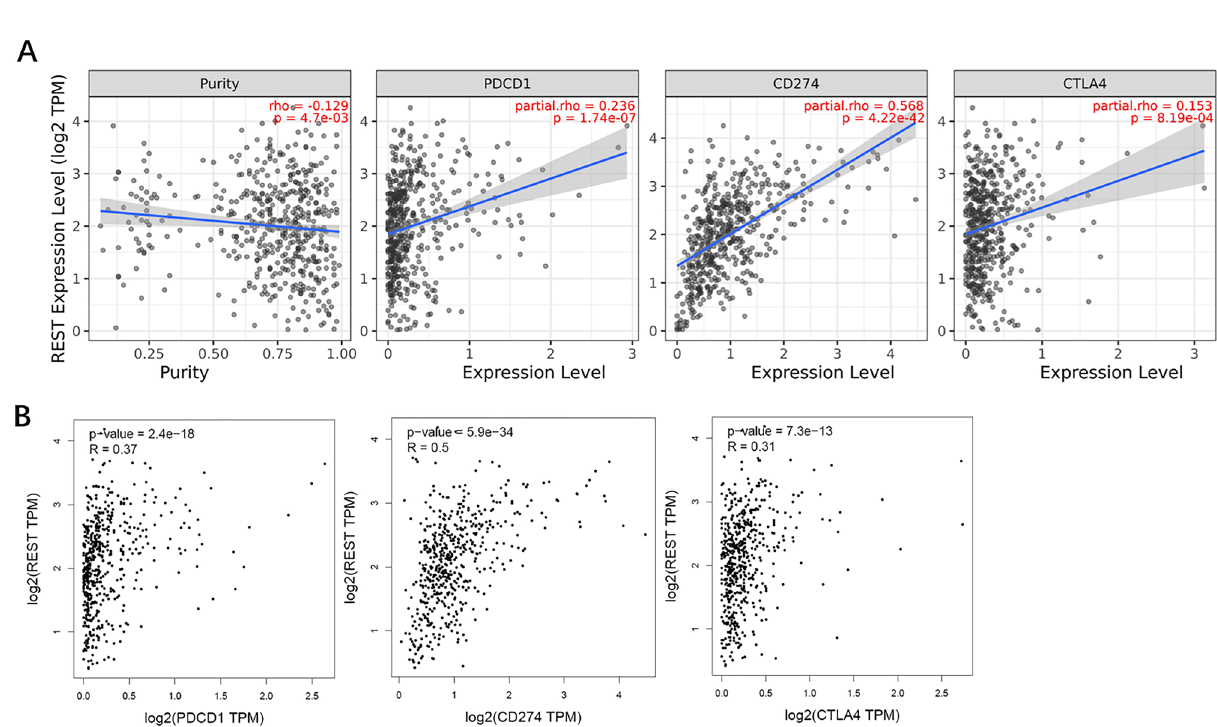
Figure 5. Relationship between REST and immune checkpoints in glioma. ( A ) Spearman correlation of REST with expression of PD-1, PD-L1, and CTLA-4 in glioma by TIMER2 (http:// timer. cistr ome. org/). ( B ) The expression correlation of REST with PD-1, PD-L1, and CTLA-4 in glioma by GEPIA2 (http:// gepia. cancer- pku.